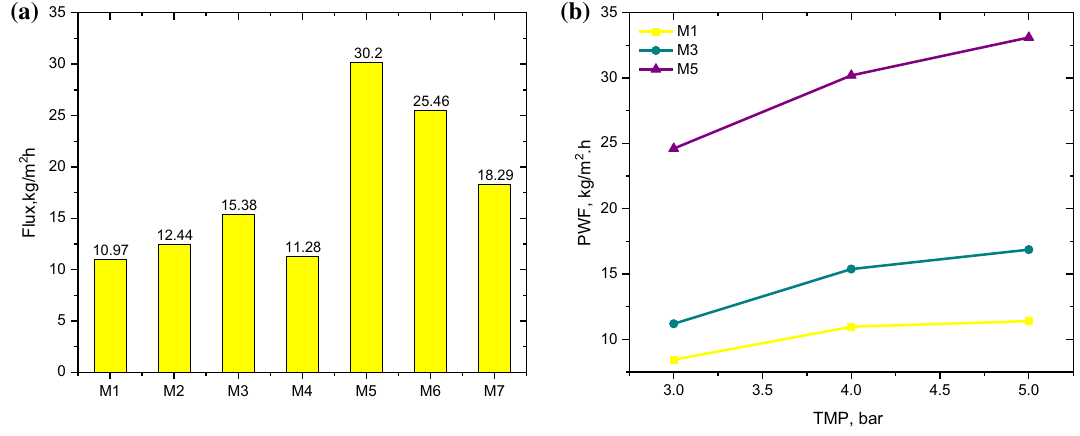
Fig. 5 Pure water flux of all the fabricated membranes at the pressure of 4 bar ( a ) and the pure water flux of M1, M3 and M5 at different operat- ing pressures ( b